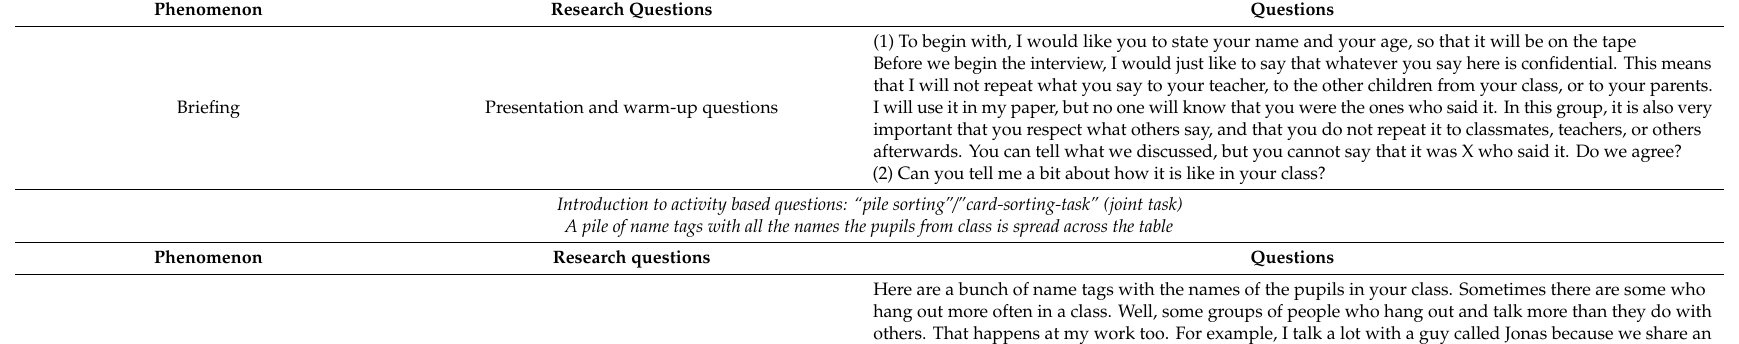
Table A1. Interview guide 1: Social categories and identities in the